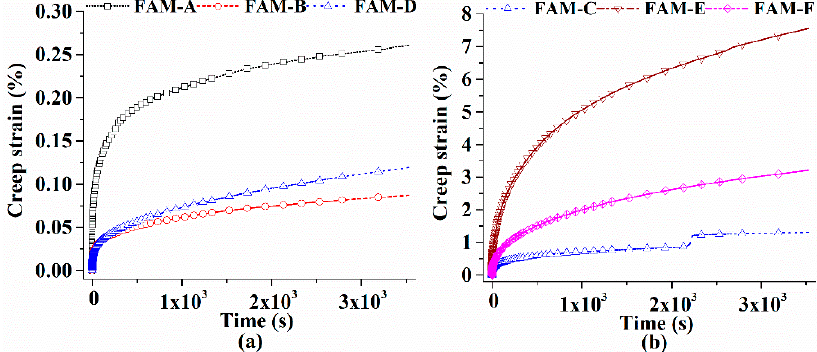
Figure 13. Creep strain versus time of FAM at 45 °C: ( a ) small strain group, and ( b ) great strain group.